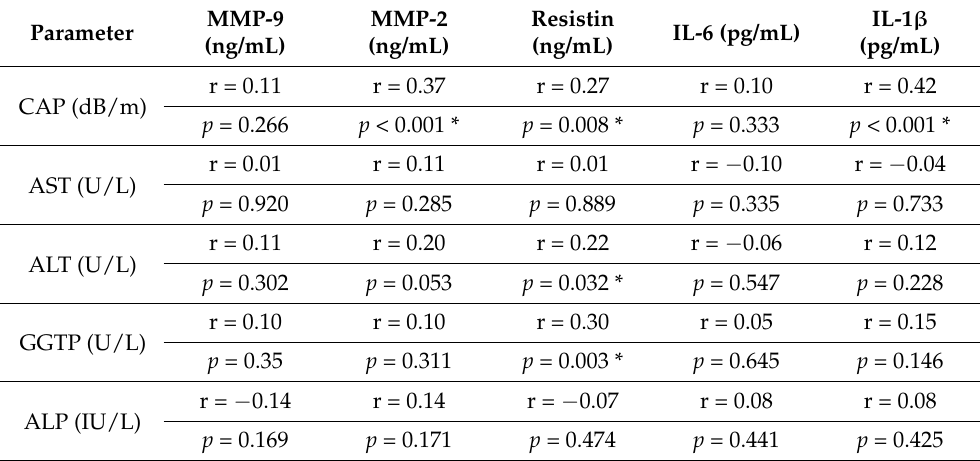
Table 6. Correlations between parameters evaluating liver condition and adipokines and cytokines in unstimulated saliva of all persons qualified for the study.